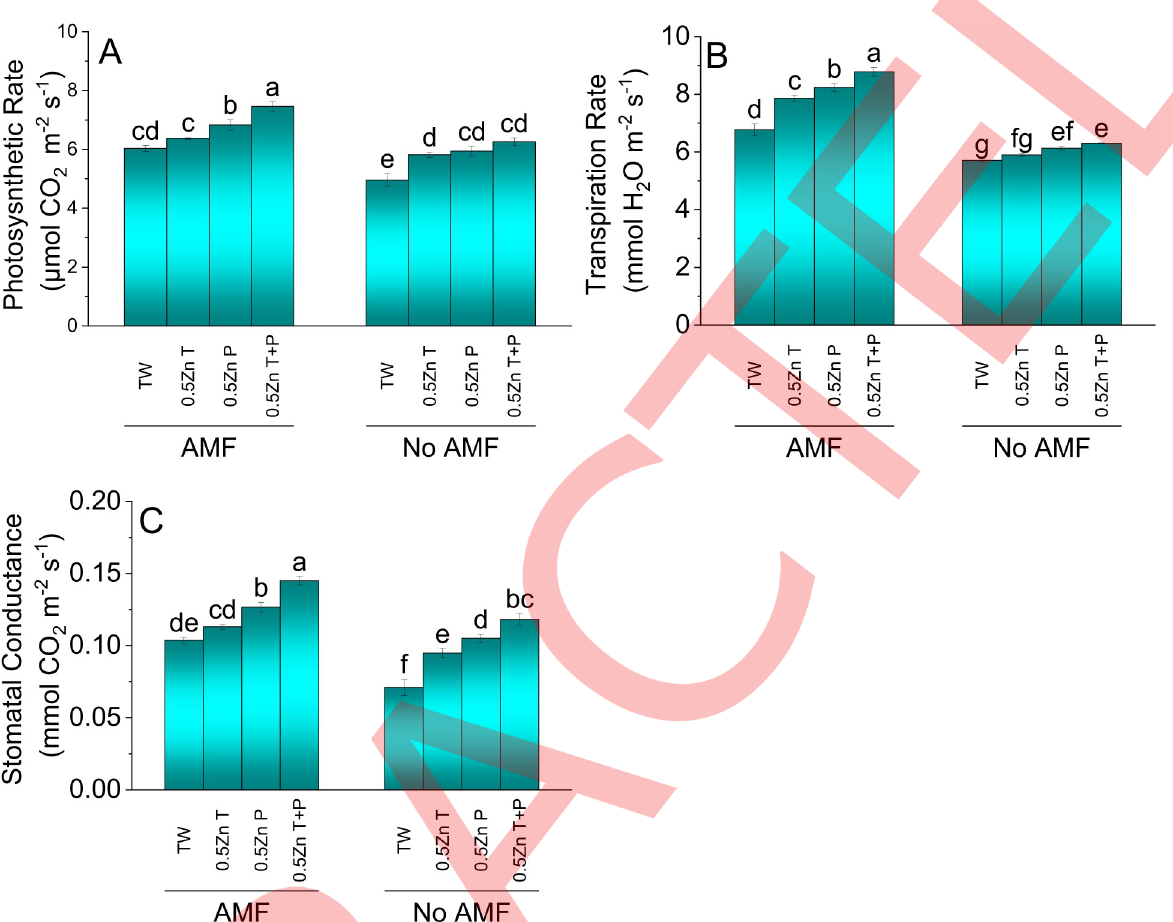
Fig 3. Effect of zinc foliar application at tillering and panicle stages with and without AMF inoculation on photosynthetic rate (A), transpiration rate (B) and stomatal conductance (C) in rice leaves. Bars are means of 3 replicas ± SE. Variable letters on bars indicate significant difference at p � 0.05 according to LSD test. TW = tap water (control); T = tillering stage; P = panicle stage; Zn = zinc.